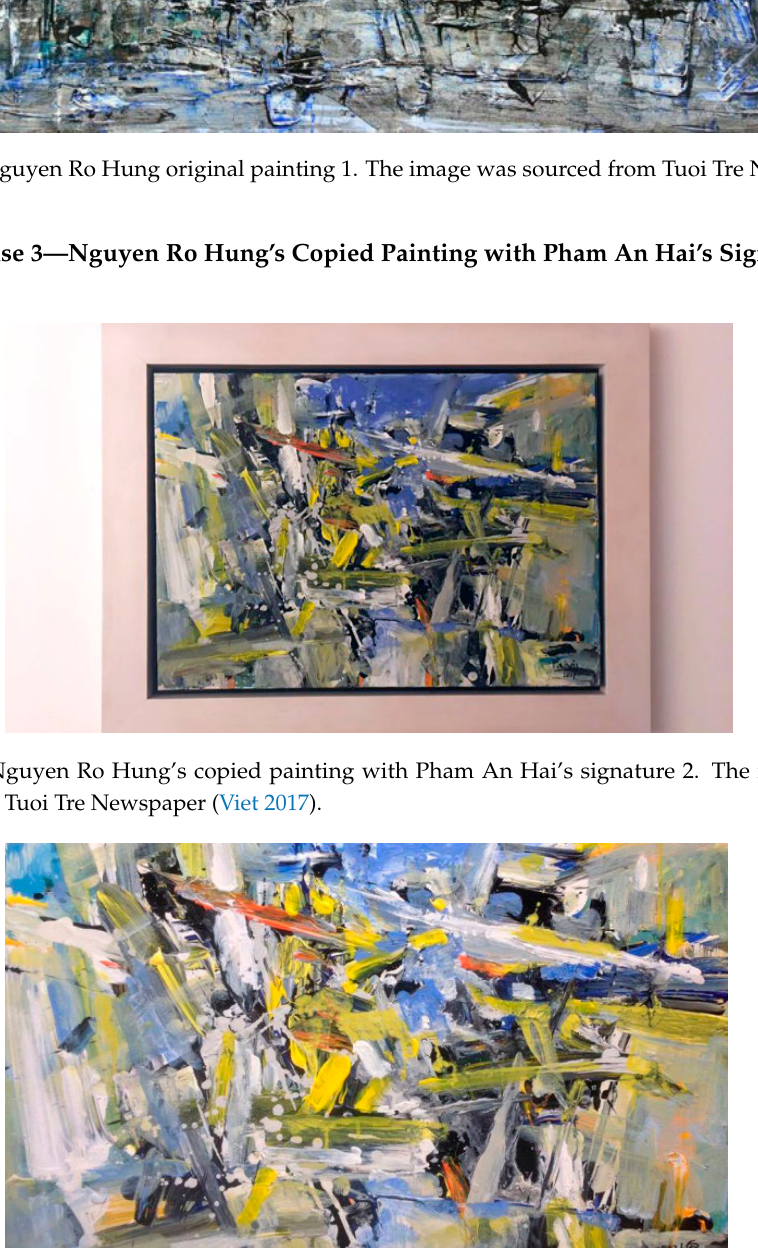
Figure A4. Nguyen Ro Hung’s copied painting with Pham An Hai’s signature 2. The image was sourced from Tuoi Tre Newspaper (Viet 2017).